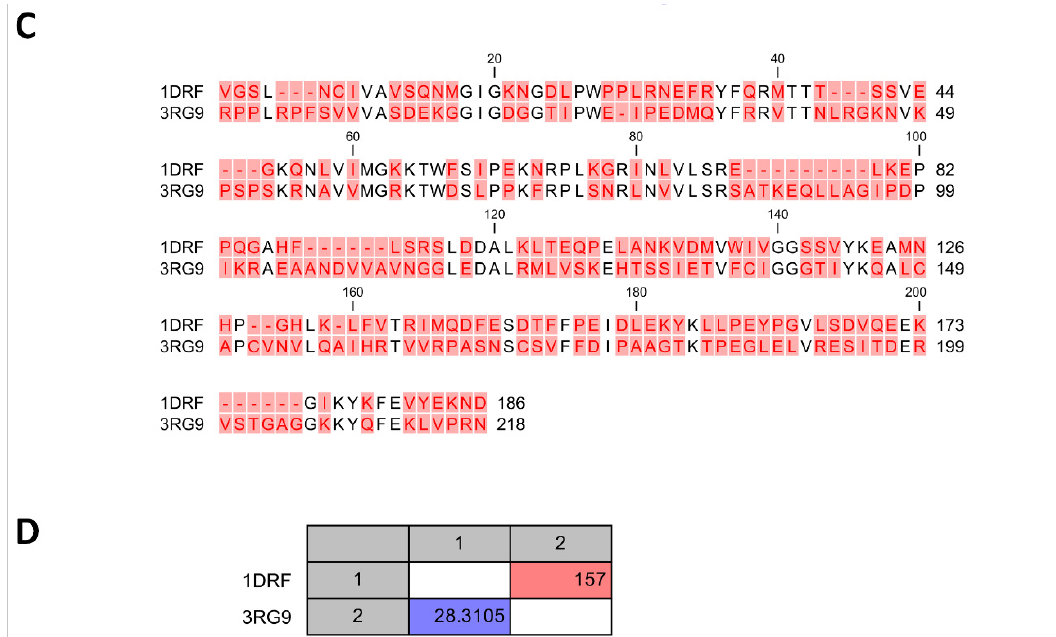
Figure 2. The ligand interactions and docking site of raltitrexed with DHFR. ( A ) The ligand interac- tions of raltitrexed with Trypanosoma brucei dihydrofolate reductase. ( B ) The docking site of raltitrexed with Humans dihydrofolate reductase. Hydrogen bonds in violet arrows, pi-pi stacking in green sticks, salt bridges in multicolored sticks and halogen bonds in amber. ( C ) Pairwise alignment of human (1DFR) and T. brucei (3RG9) DHFR. The different residues are highlighted in pink. ( D ) Pairwise comparison statistics of human (1DFR) and T. brucei (3RG9) DHFR. The number of amino acid differences is highlighted in red. The identity% is highlighted in blue.